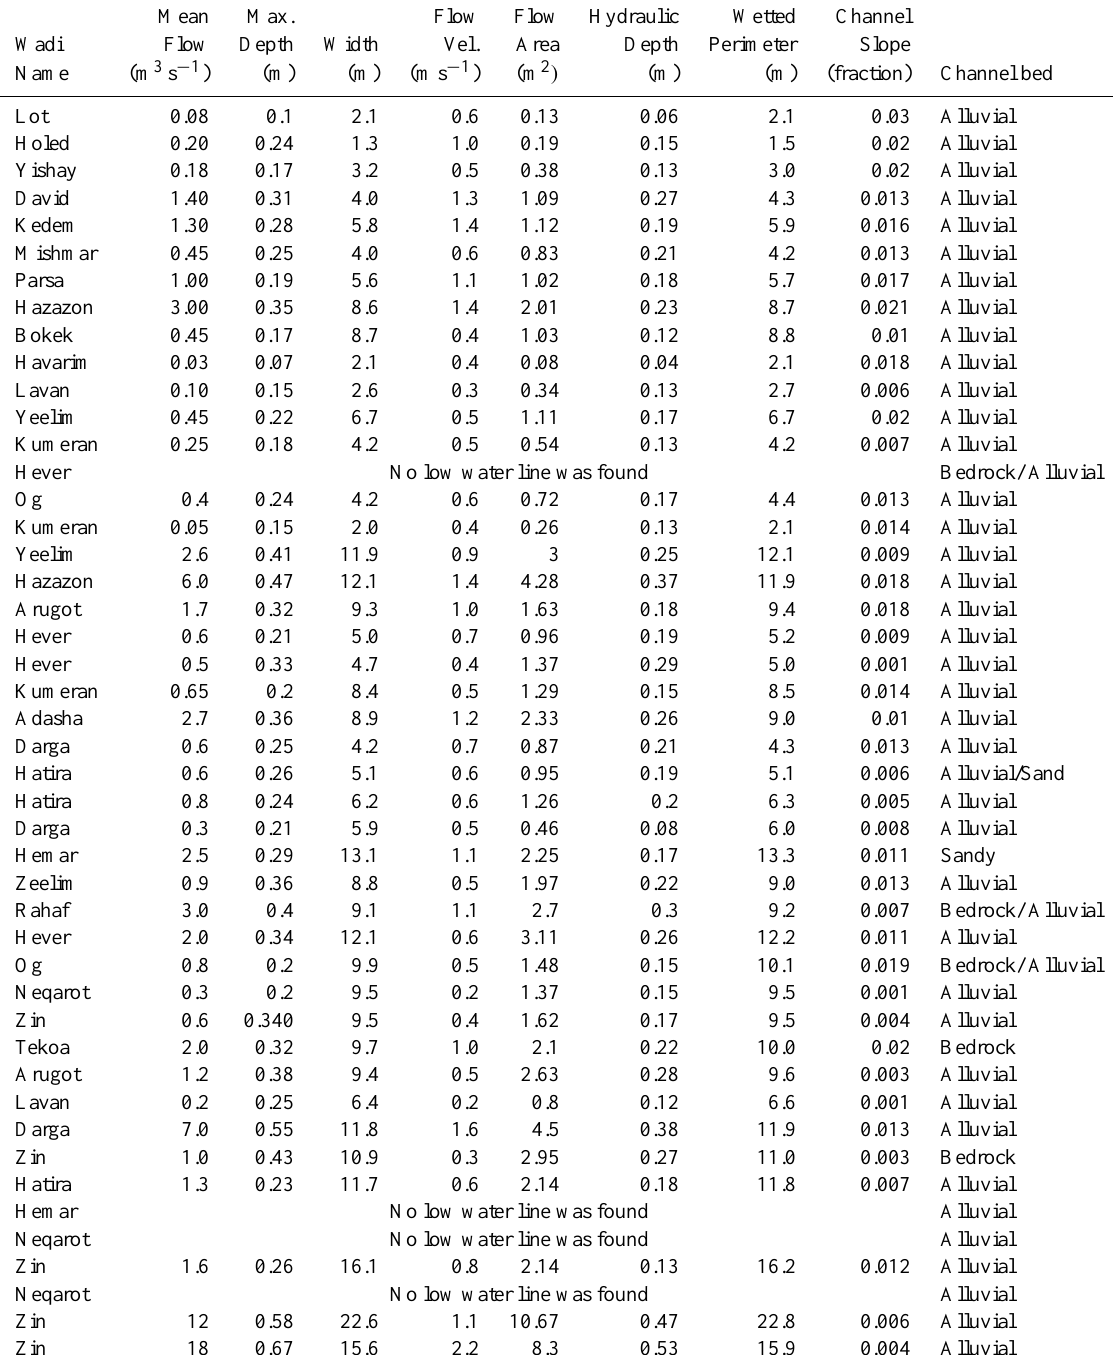
Table A2. Cross sectional properties of the AFIG. Mean Max. Flow Flow Hydraulic Wetted Channel Wadi Flow Depth Width Vel. Area Depth Perimeter Slope